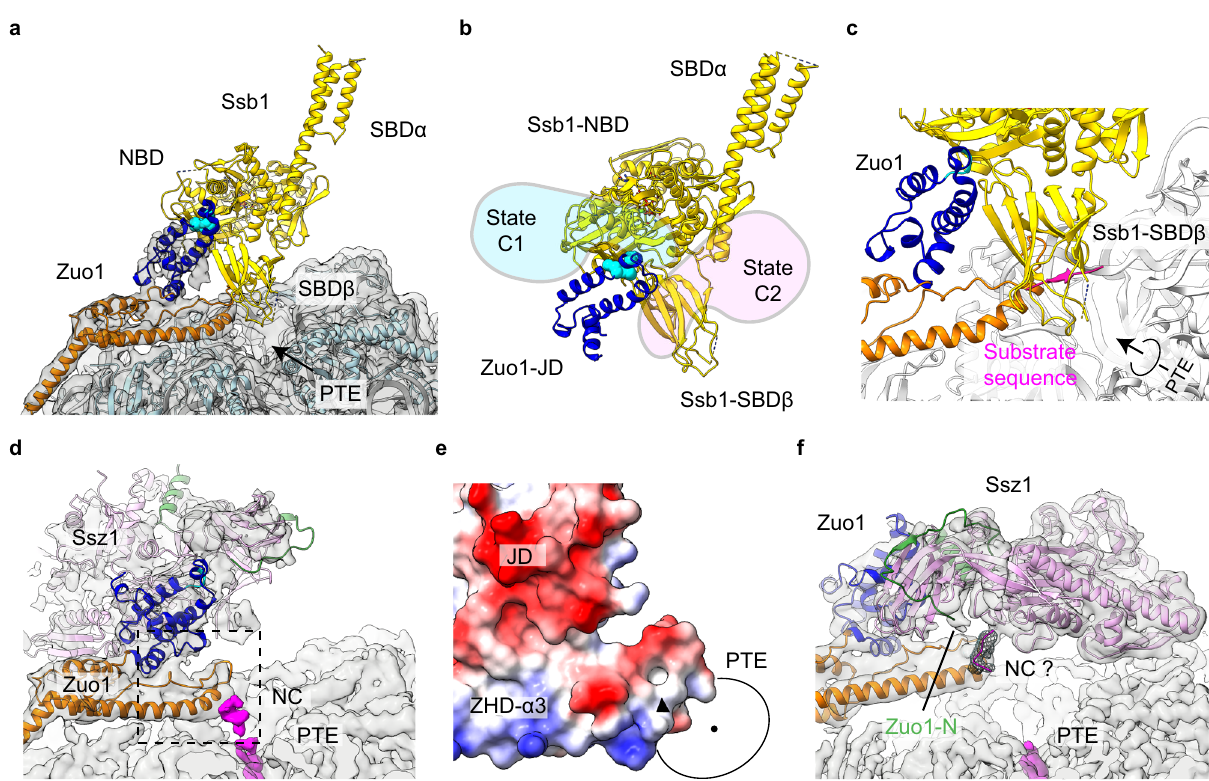
Fig. 6 Docking of Ssb-ATP on the 80S structure of the RNC-RAC-Ssb1 dataset. a Superimposition of the atomic model of Ssb1-ATP (5TKY) onto the RNC-RAC-Ssb1 structure (Map 2.2 in Supplementary Fig. 6), based on the structural alignment to JD DnaJ -DnaK-ATP complex (PDB 5NRO). Ssb1 is colored gold. There is no steric clash between Ssb1 and the 60S subunit. b Steric clash between Ssb1-ATP and Ssz1 in State C1 and C2 from the RNC-RAC dataset. c Magni fi ed view of the PTE region in a . A putative substrate (magenta) of Ssb1 SBD was derived from the crystal structure of DnaK-substrate complex (PDB 4R5I). The arrow indicates the direction of nascent chain elongation. d Magni fi ed view of the PTE region in the structure of State C1 from the RNC- RAC dataset (Map 3.1 in Supplementary Fig. 9). Nascent chain is shown in magenta. e Boxed region in d shown in electrostatic surface. The negatively and positively charged surface is shown in red and blue, and the hydrophobic surface in white. The black triangle indicates the contact site of the nascent chain in State C1 ( d ). f Magni fi ed view of the PTE region in the structure of State C2 from the RNC-RAC dataset (Map 3.5 in Supplementary Fig. 9). Nascent chain in the peptide tunnel is shown in magenta. A strong density piece, that might be a fragment of the nascent chain, is highlighted in mesh